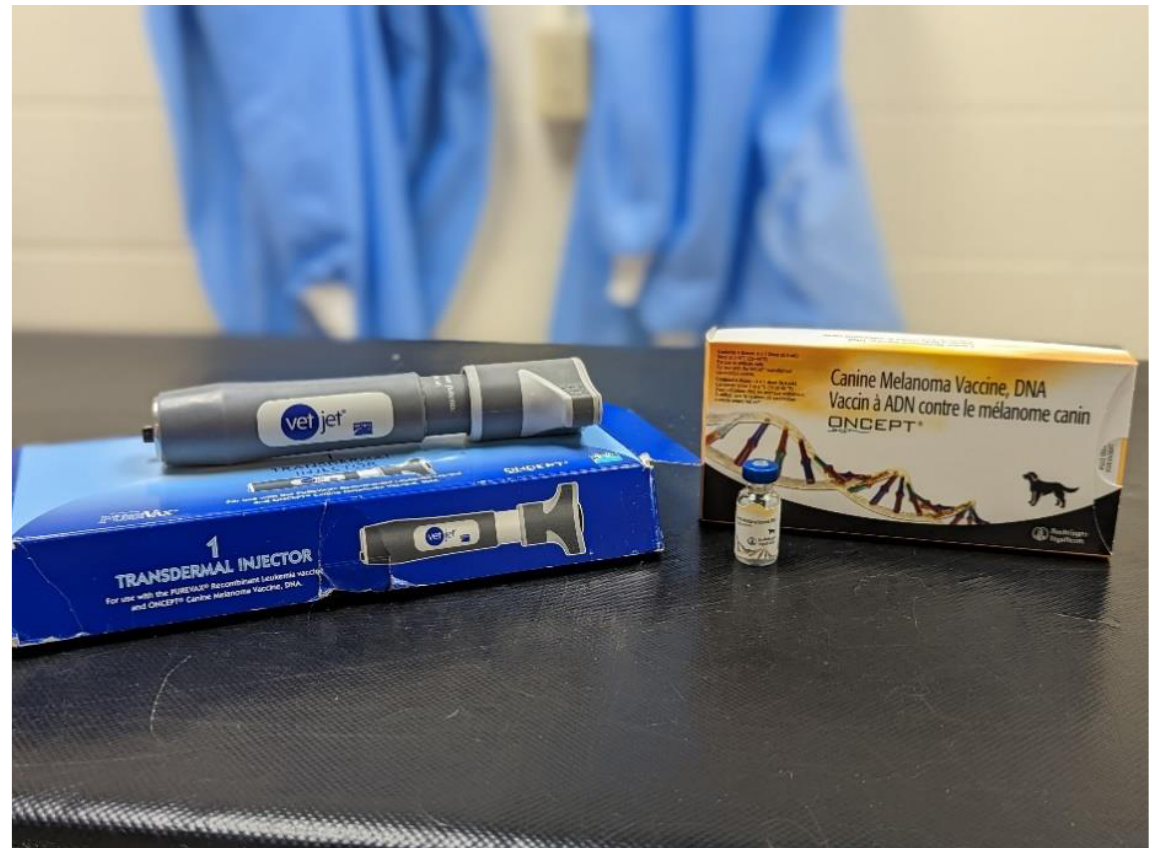
Figure 1. Photograph of Oncept melanoma vaccine drug box and vial, along with Vet Jet transdermal injector.